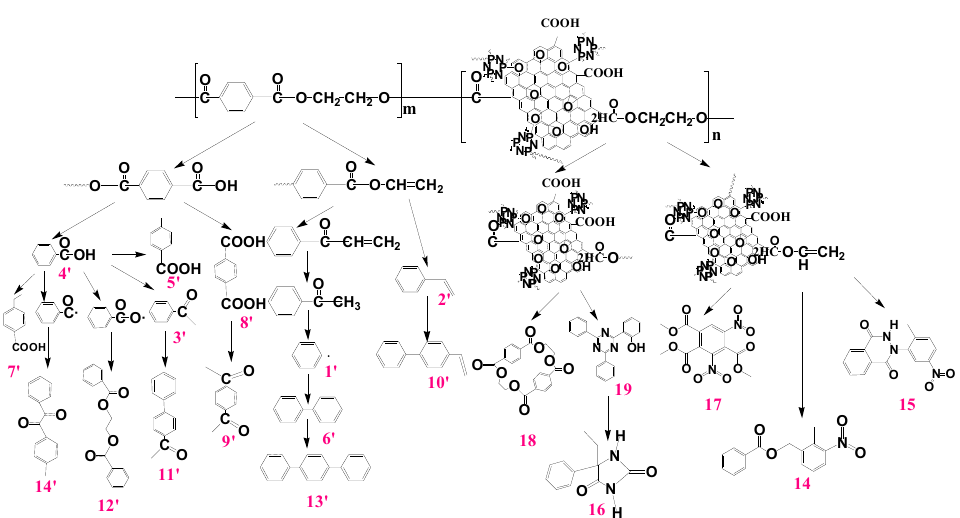
Figure 11. Proposed pyrolysis processes for PET-0.4G-0.2H. Compared with neat PET, the pyrolysis products after the addition of the 0.4G-0.2H represents some differences in the relative concentrations and composition. The proposed pyrolysis process for PET-0.4G-0.2H is shown in Figure 11. The main pyrolysis products were 39.6% Benzoic acid, 11.3% Terephthalic acid 7.2% p-Acetylacetophenone, 5.2% ben- zene, 4.8% Methyl benzoate, 4.6% Terephthalic acid, 4.3% Bibenzene, 3.7% Styrene,